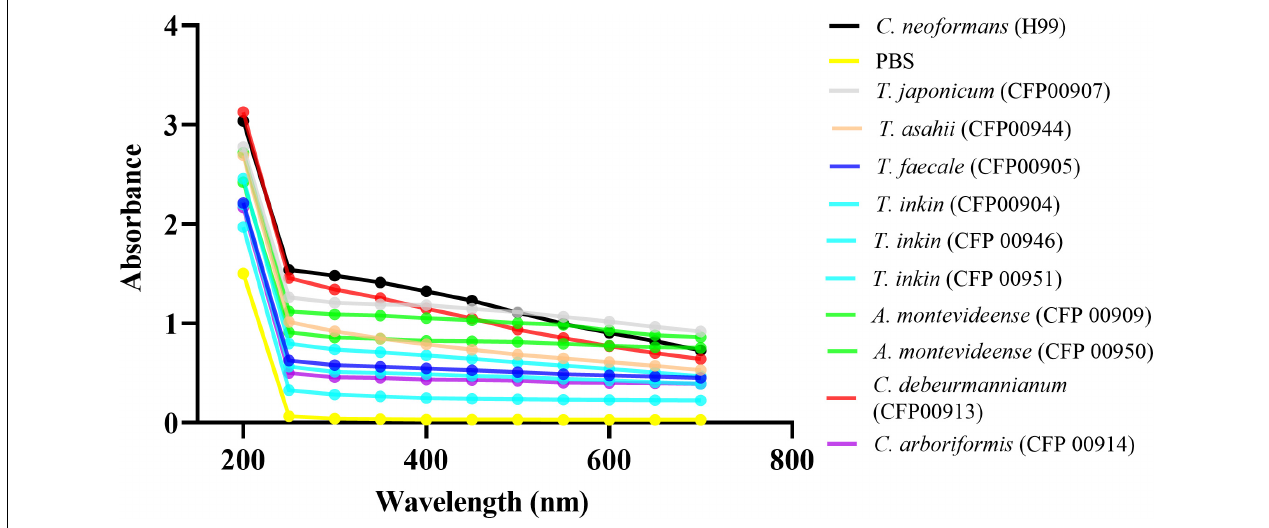
FIGURE 4 | The UV-visible spectra of melanins from 10 different Trichosporonaceae strains. The Cryptococcus neoformans var. grubii H99 strain was used as a control. The optical densities to construct the spectra were obtained in triplicate.